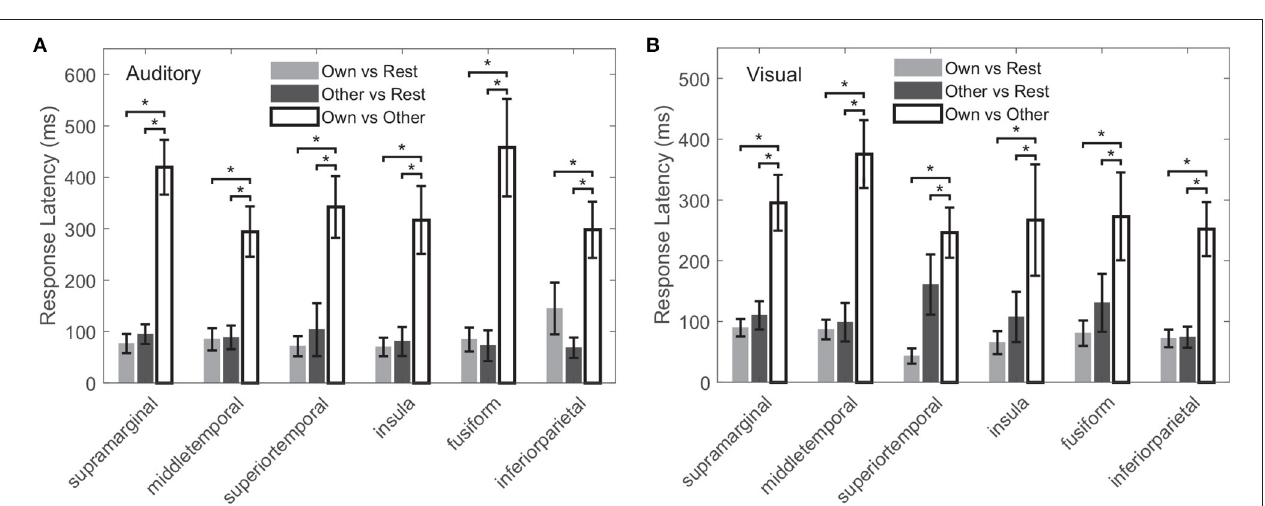
FIGURE 9 | Latencies for own name activation, other name activation, and the difference between the two types of responses, marked as “Own vs. Rest,” “Other vs. Rest,” and “Own vs. Other,” respectively. (A,B) Correspond to the auditory and visual modality, respectively. The error bar indicates the standard error across all cross-modal contacts within the region. The “*” indicates the significant difference ( p <